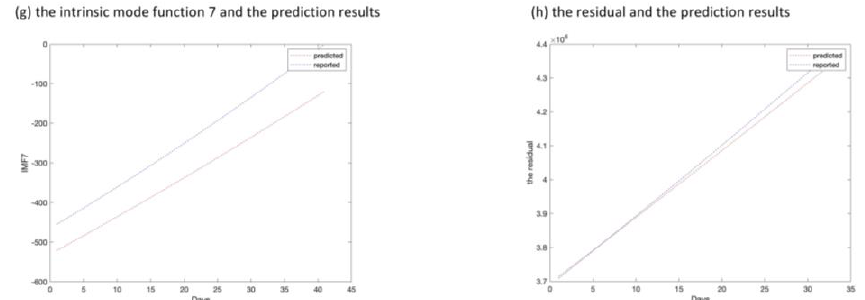
Figure 6. Comparison of predicted and reported values of intrinsic mode functions and residual sequence. ( a – h ) The pictures depict the decomposed sequences and the predicted results on the test set through the long short-term memory model.